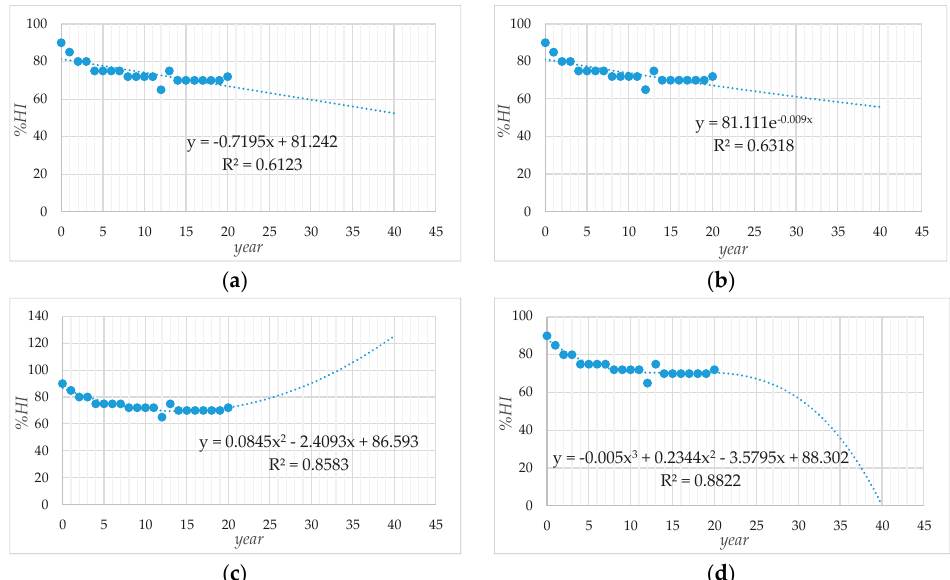
Figure 4. Regression analysis by various curve fitting functions to predict the trend of health index. ( a ) Linear function, ( b ) exponential function, ( c ) 2nd order polynomial function, and ( d ) 3rd order polynomial function.